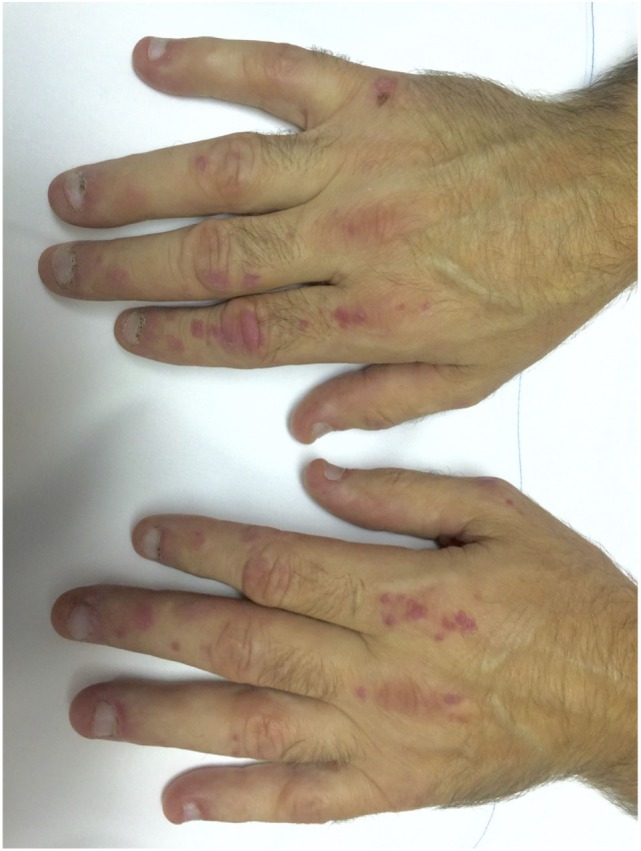
Gottron’s papules in a case of dermatomyositis.